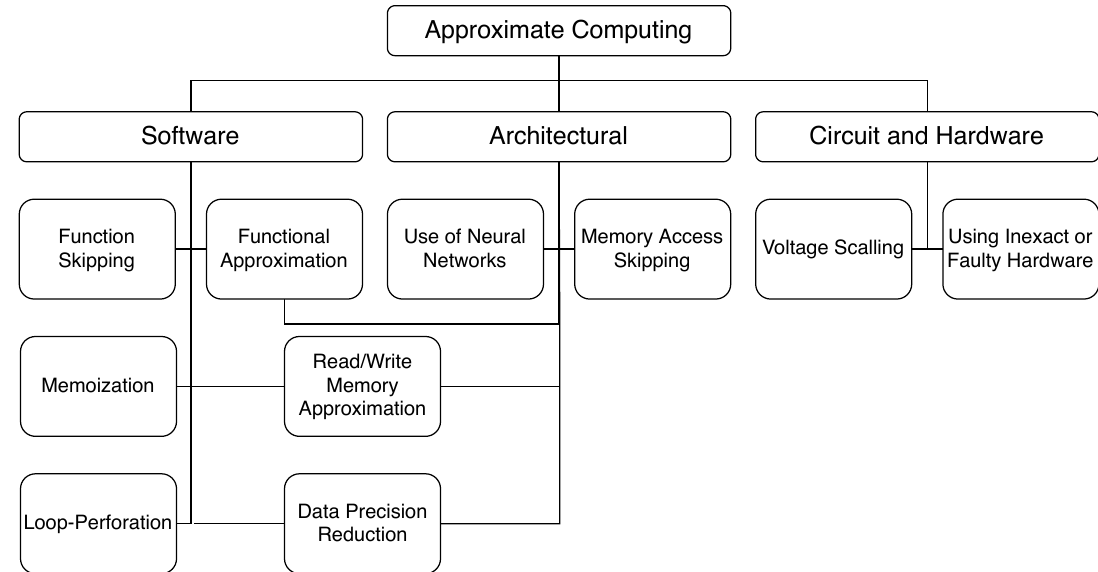
Figure 1. Approximate computing